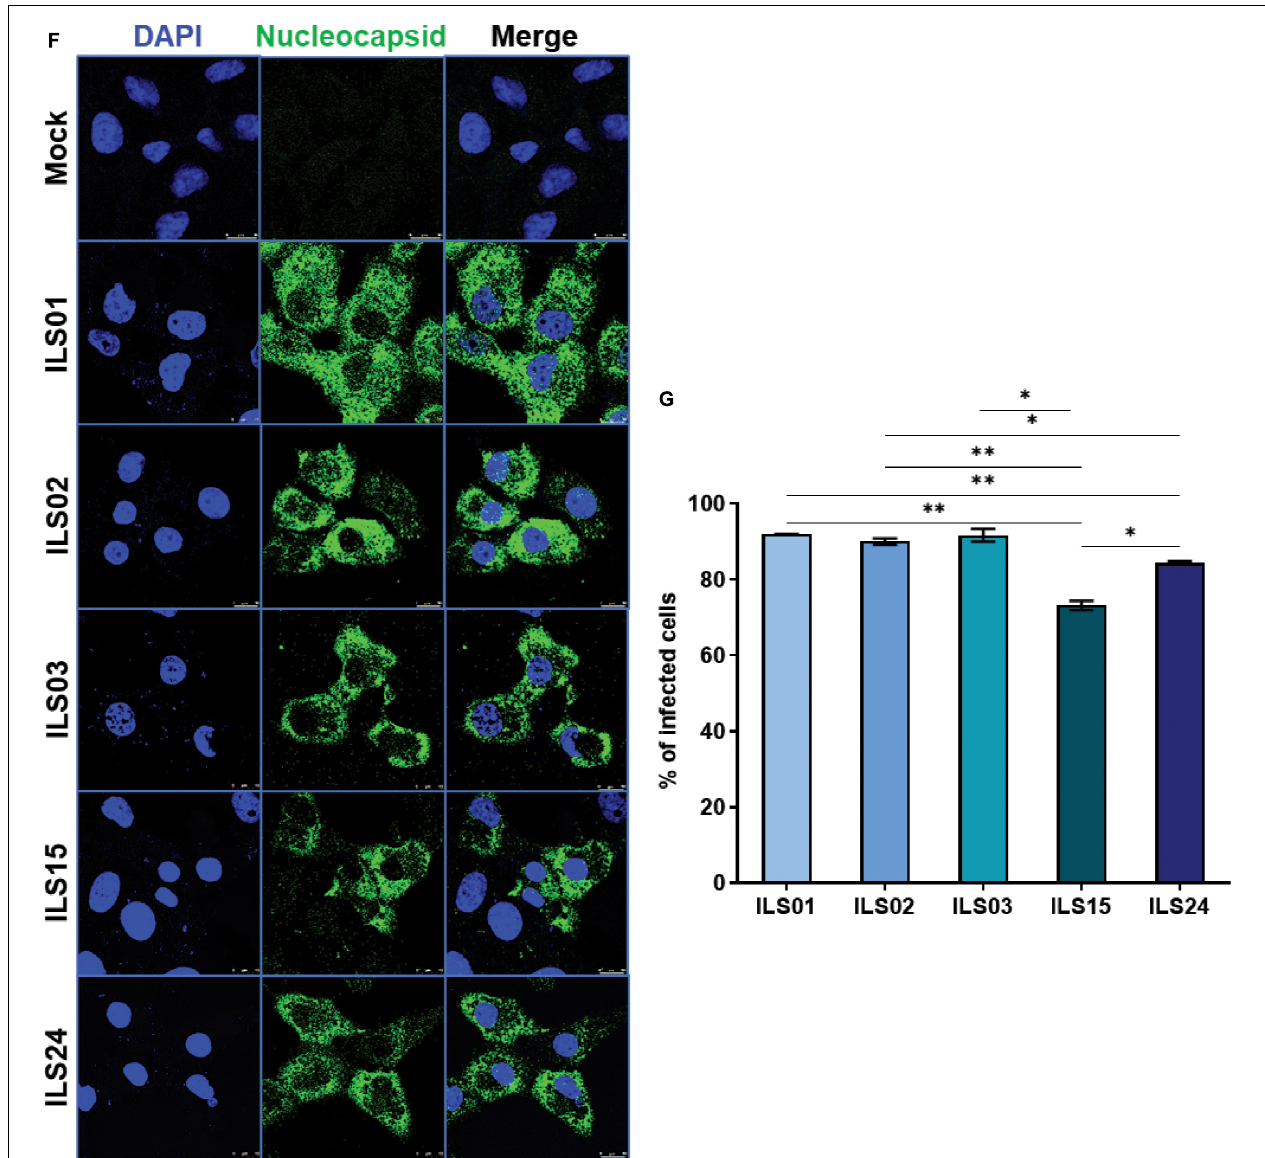
FIGURE 1 | Characterization of isolated SARS-CoV-2 circulating strains. The SARS-CoV-2 circulating strains were isolated from the swab samples of COVID-19 patients via a sequential passage in Vero E6 cells, as described in the “Materials and Methods” section. The viral titers, cytopathic effects, and gene expression were determined in the 10th passage of viral stocks. Quantification of viral titers of the five isolates by plaque-forming unit (PFU) assay (A) and TCID50 assay (B) . Absolute quantification of viral genome copies in all five isolates using gene-specific primer and probes targeting SARS-CoV-2 nucleocapsid and ORF-1 gene (C) . Bright-field images depicting cytopathic effect in Vero E6 cells infected with the five isolates (D) . Western blot analysis of infected Vero E6 cell lysates with antibodies against SARS-CoV-2 spike and nucleocapsid (E) . GAPDH was used as a protein loading control. Quantification was done by densitometry using ImageJ software and the number represented the fold of each (spike or nucleocapsid) value normalized to the value of GAPDH. Detection of SARS-CoV-2-infected cells by immunofluorescence using an antibody against SARS-CoV-2 nucleocapsid in Vero E6 cells infected with 0.1 MOI of respective isolates (F) and quantification of the percentage of infection 48 hpi (G) . Data are the mean value ± SD ( n = 3). Statistical significance was determined using one-way ANOVA (A,B,G) and two-way ANOVA (C) and; * P < 0.05; ** P < 0.01; *** P < 0.001; ns, not significant ( P > 0.05). Non-significant value is not